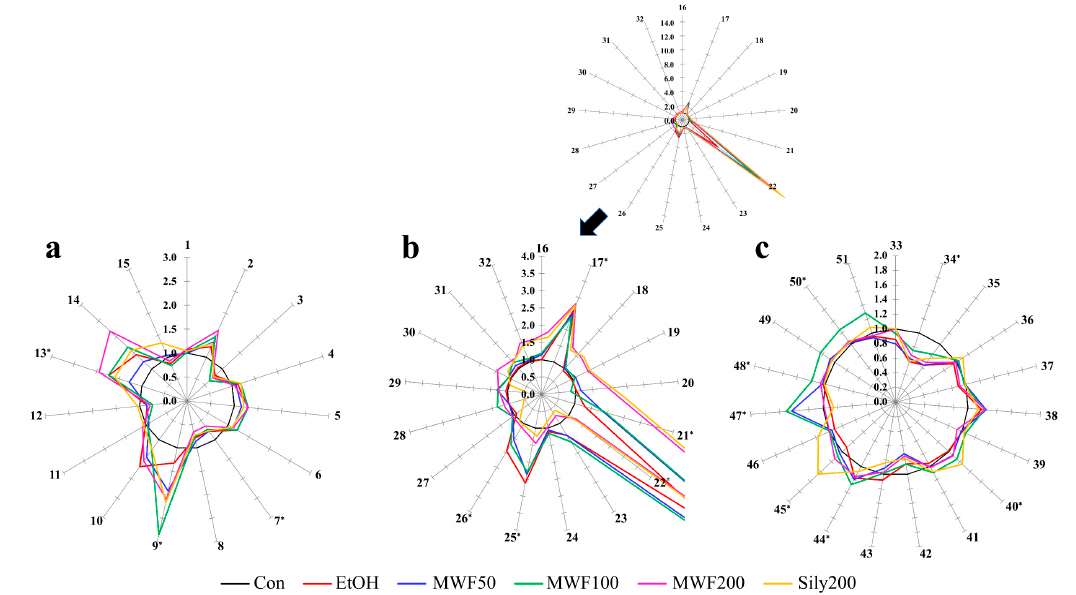
Figure 2. Star symbol plots of ( a ) amino acids, ( b ) organic acids, ( c ) fatty acids in serum for the Con, EtOH, MWF 50, 100, 200, and Sily200 groups mean values. Plots are drawn based on the mean levels of 15 amino acids, 17 organic acids, and 19 fatty acids as the variables after normalization to the corresponding normal mean values. * Significant metabolites in ANOVA. Ray: 1= Alanine; 2= Glycine;